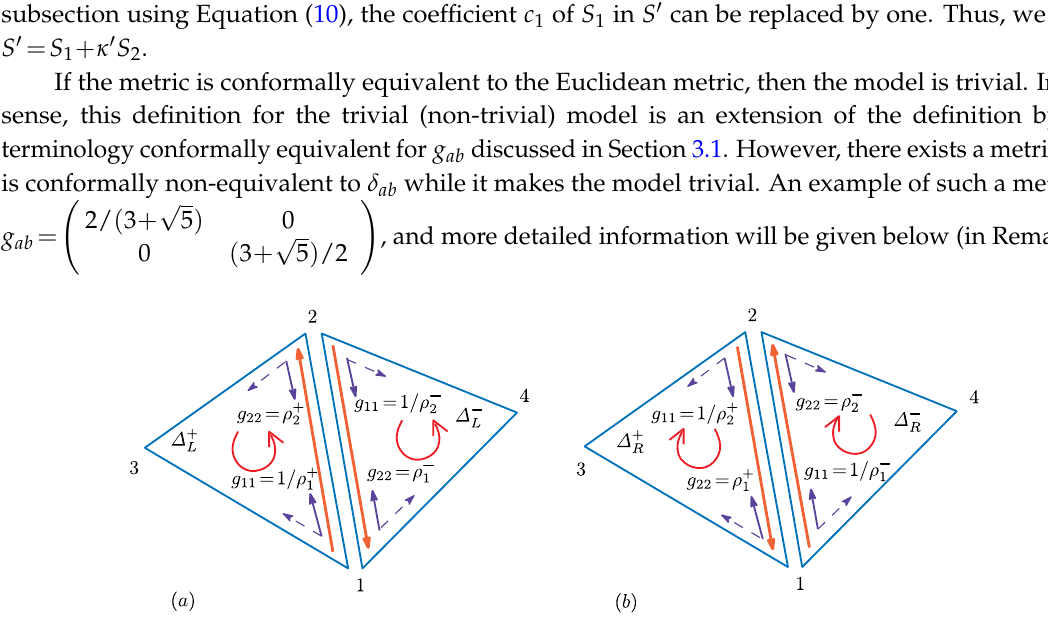
(inside view) of ∆ ± in (a). The direction R L and ∆ ± L R